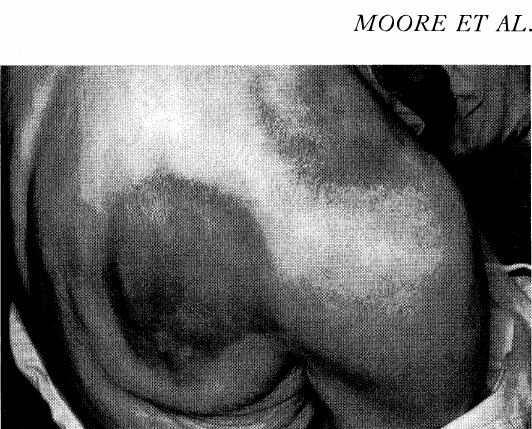
Fig. I. Two areas of discoloration are seen involving the right shoulder and represent cutaneous gangrene. Both le- sions were crepitant to